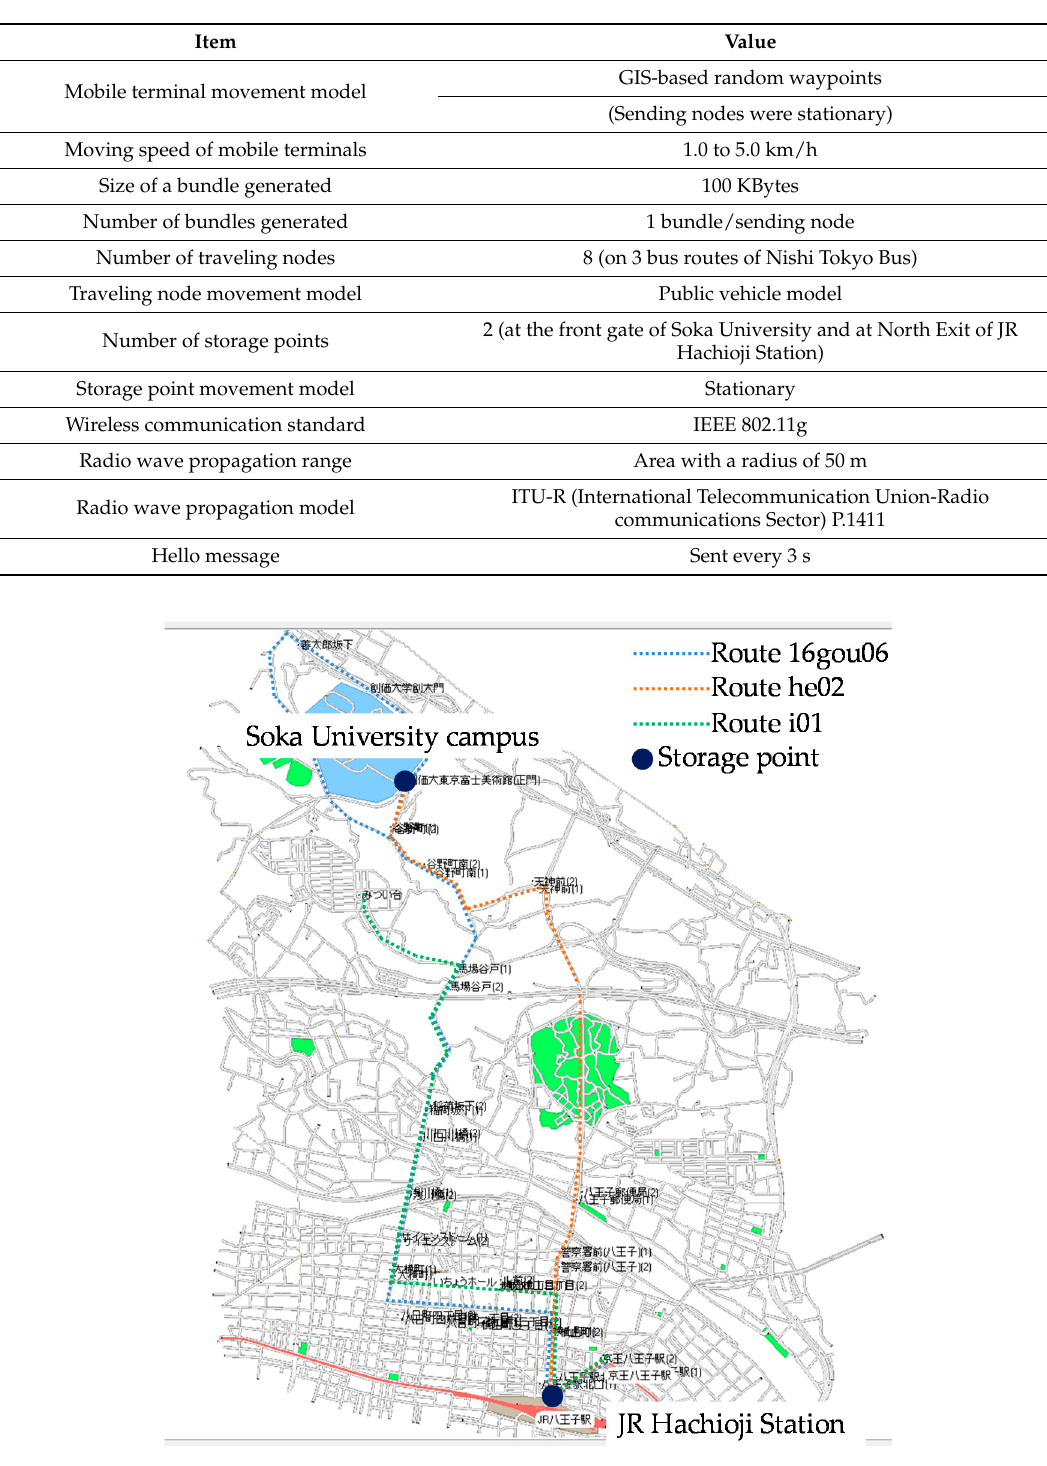
Figure 18. Routes of the traveling nodes and locations of storage points.